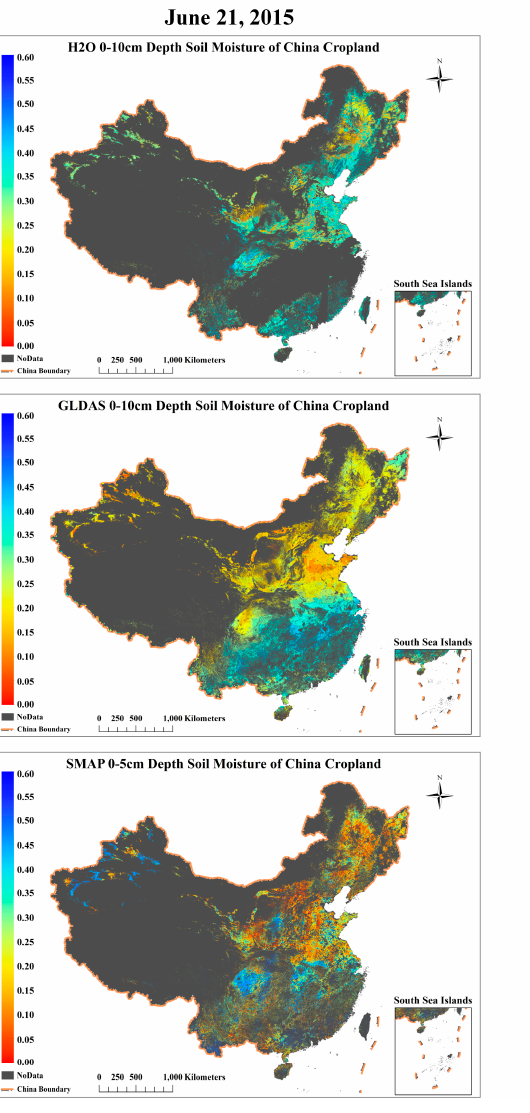
Figure 8. H2O model estimated soil moisture at 0–10 cm depth, SMAP radar estimated soil moisture at 0–5 cm depth and GLDAS estimated soil moisture at 0–10 cm depth maps for cropland in China on 21 June and 1 July 2015.